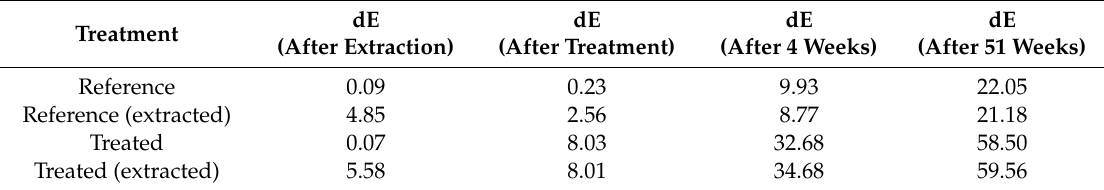
Figure 5. Scans of the specimens of set 2 treated with iron (II) sulfate before and after 42 and 91 weeks of exposure. Upper row = not exposed to sunlight, lower row = exposed to sun light. Table 2. Color di ff erence (dE) of the extracted and non-extracted spruce specimens of sample set 1 at di ff erent experimental stages referring to the color before extraction. Treated = sulfate-treated iron (II), R = untreated reference.